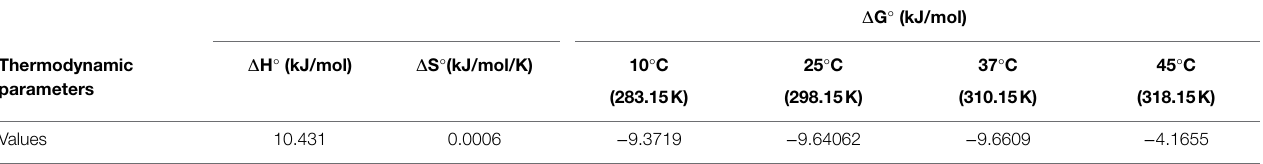
TABLE 4 | Thermodynamic parameters for B. altitudinis MT422188 biosorption.